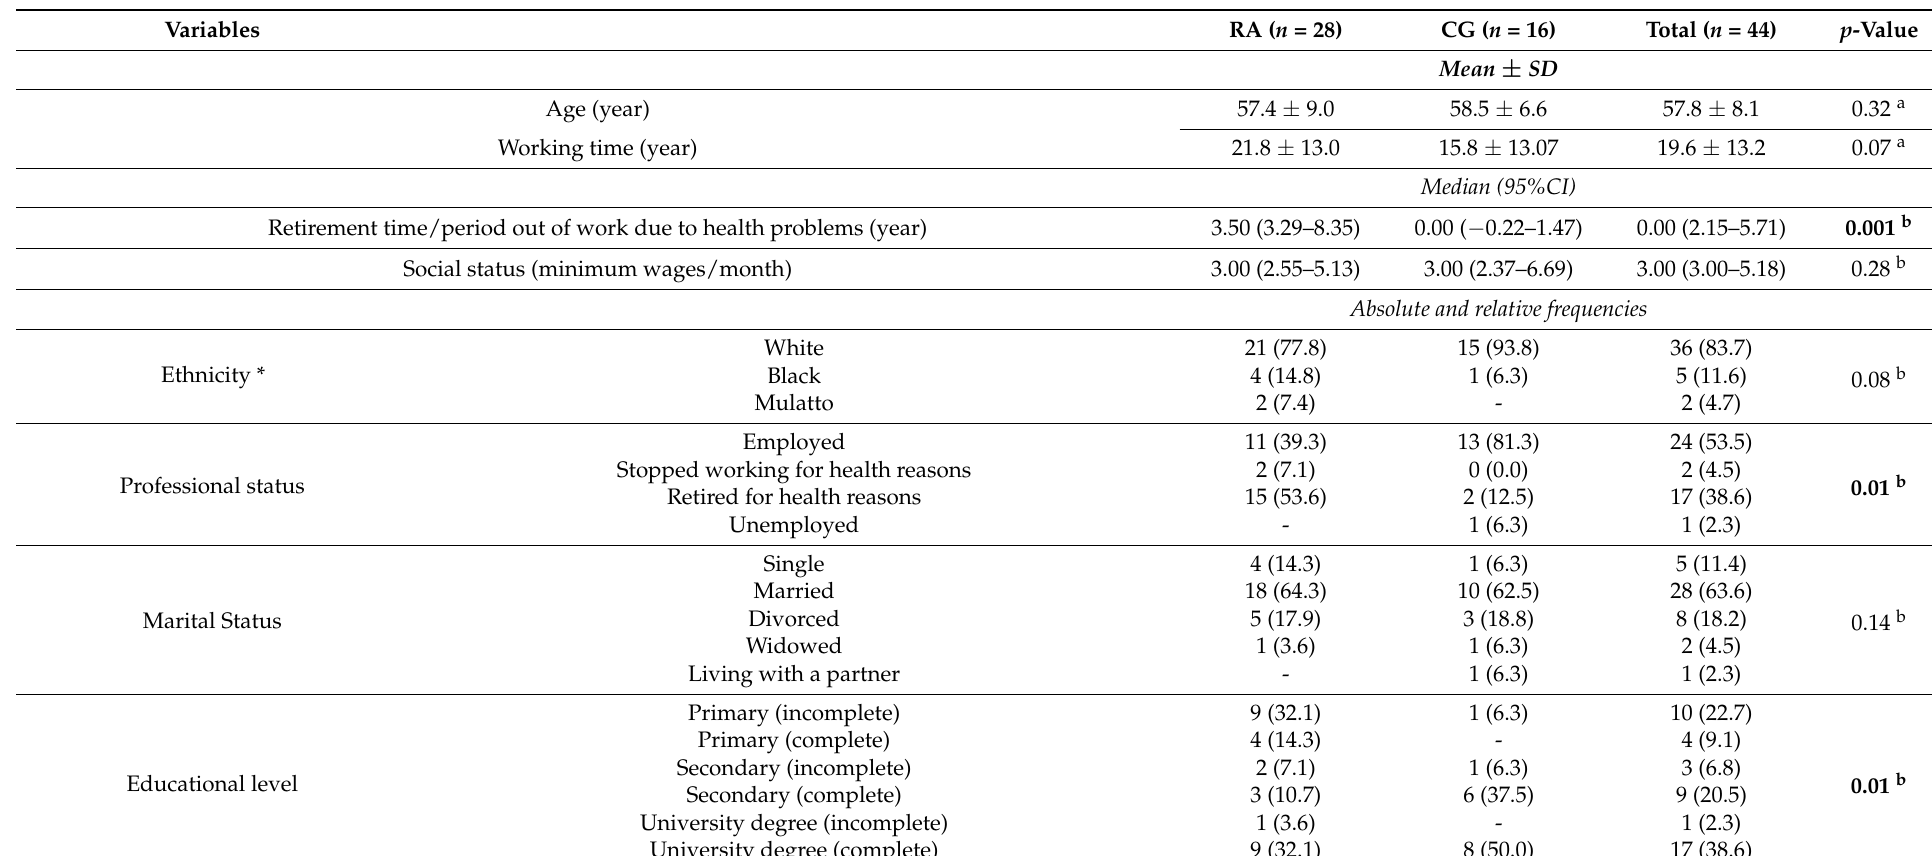
Table 2. Summary of demographic, clinical, and disease